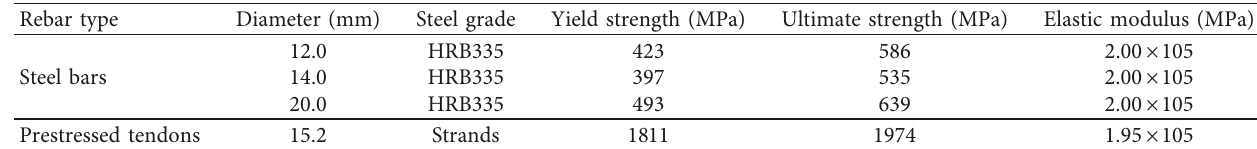
Figure 1: Details of prestressed fabricated concrete frame KJ-6. Table 1: Mechanical properties of steel bars and prestressed tendons.